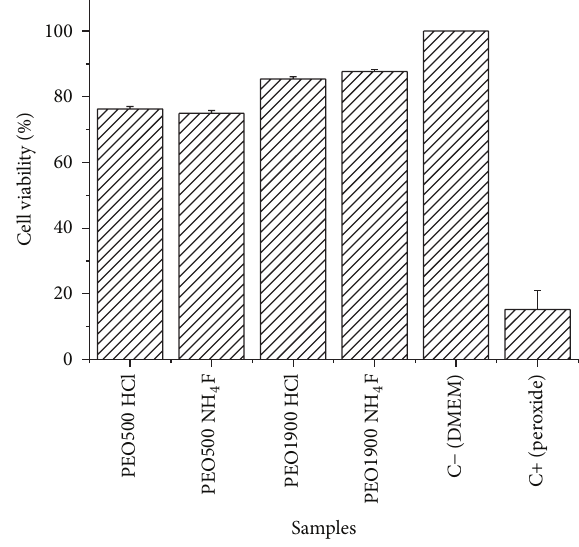
Figure 3: Cytotoxicity assay with human skin keratinocytes cells for ureasil-PEO. Results are expressed as the mean ± SD of triplicates ( 𝑛 = 3